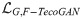
The evaluation results comparing different loss functions on four different data sets, according to the tLP metric.Loss-TecoGAN represents the loss function LG,F−TecoGAN, whilst Loss-MRMVSR represents the loss function LG,F−MRMVSR.